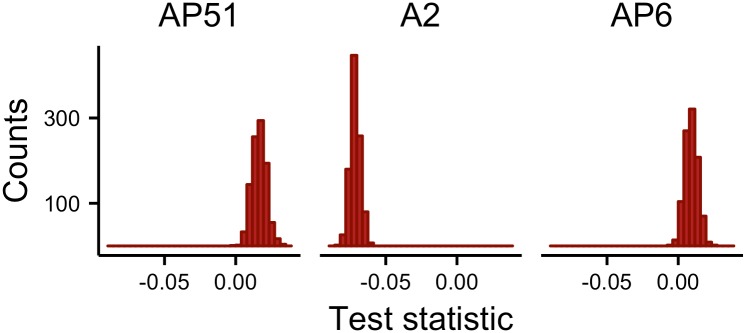
Distribution of dGD based on Dc for each of the three highways.Positive values indicate higher average differentiation of samples between opposite roadsides relative to same-roadside samples. For AP6 and AP51, over 97% of the resamplings yielded test values greater than zero. For A2, all resamplings gave values less than zero.